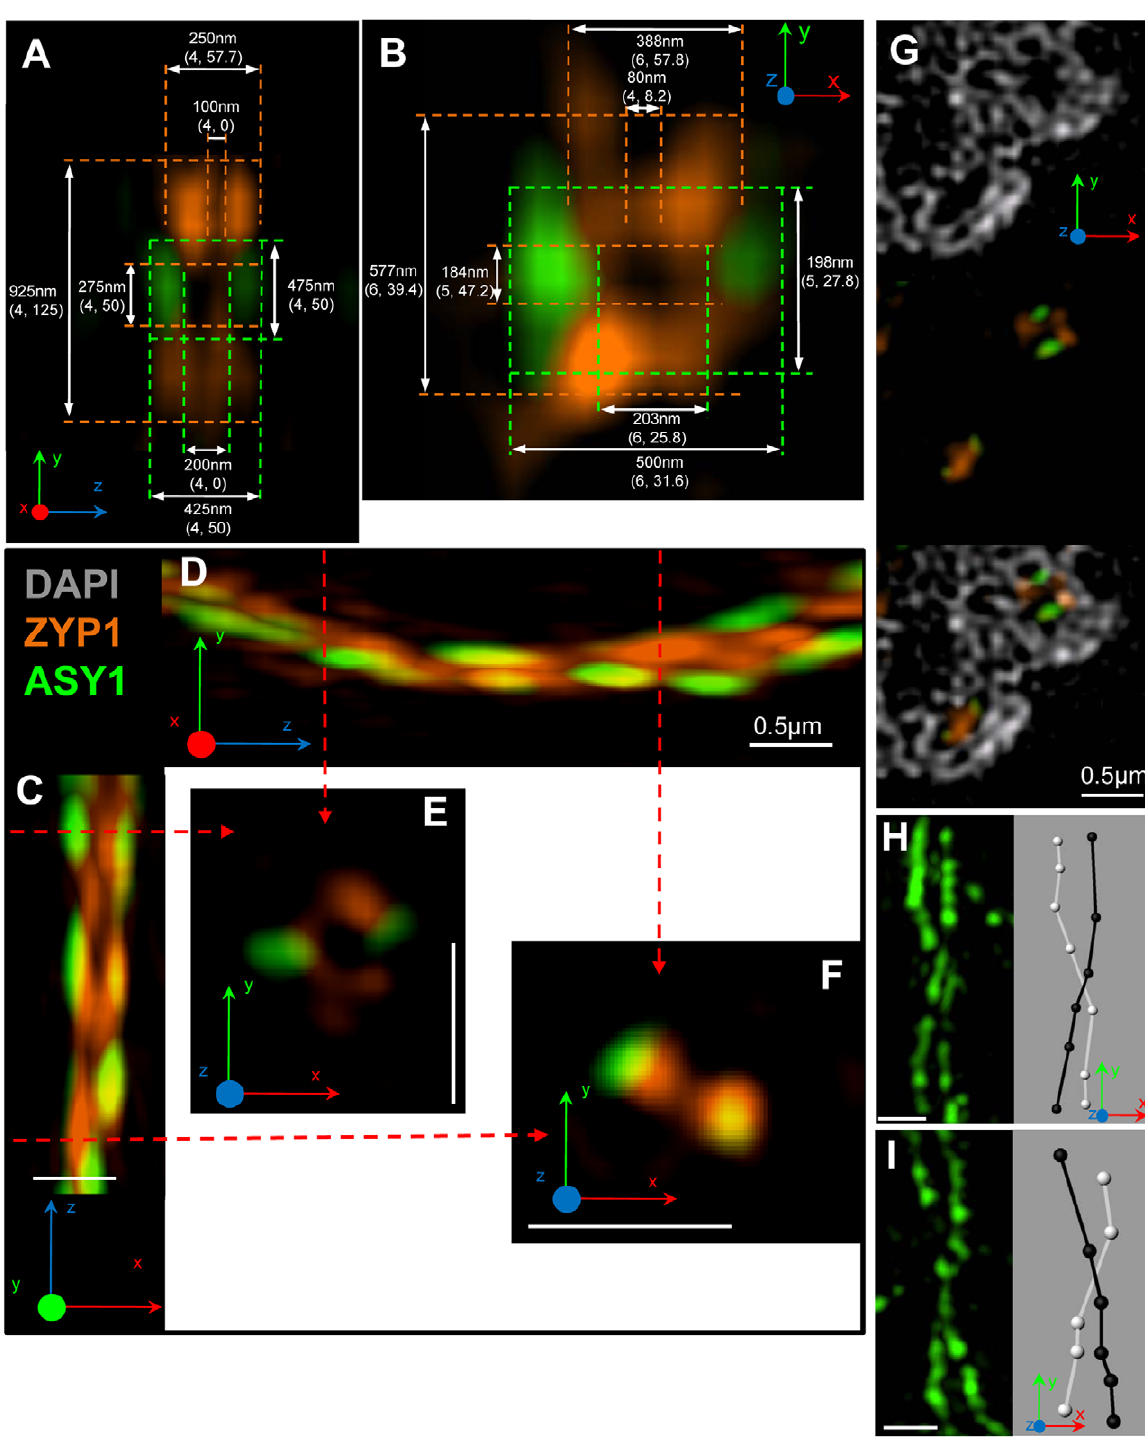
Figure 5. SC structures and features revealed by 3D-SIM. (A & B) Cross-sectional views of the variant SC structure in the yz (A) and xy planes (B) showing ASY1 (green) and ZYP1 (orange). Average dimensions of the various SC components (the number of measurements taken and the standard deviation shown in parenthesis). (C & D) An SC shown in the xz (C) and yz (D) planes, with two cross-sectional views (E & F) 2 m m apart (red arrows) showing a change in SC conformation. (G) Series of 3 images showing a single z section from a limited region of a pachytene nucleus, with DAPI (grey) in the upper pane, two SCs with different conformations in the centre pane and a merged image of the upper two panes. (H & I) Twisting of the LEs during pachytene as revealed by detecting ASY1 protein (green). A left-handed twist (H) and a right-handed twist (I) are shown, together with an interpretive diagram generated in Imaris. All images have been captured by 3D-SIM from pachytene nuclei embedded in polyacrylamide. The xyz angles shown in each image relate to the orientation of the captured image.